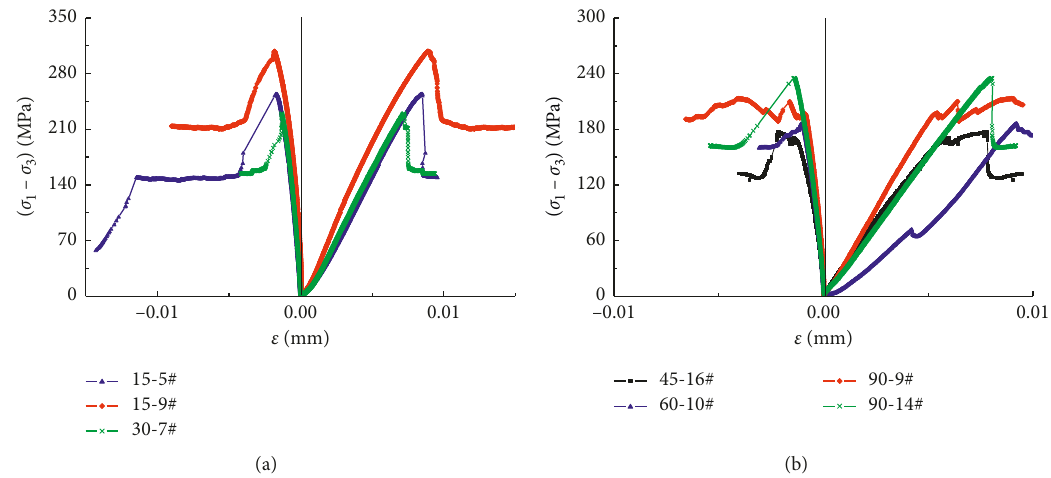
Figure 9: The stress-strain curves of the specimens: confining pressure of 40MPa.